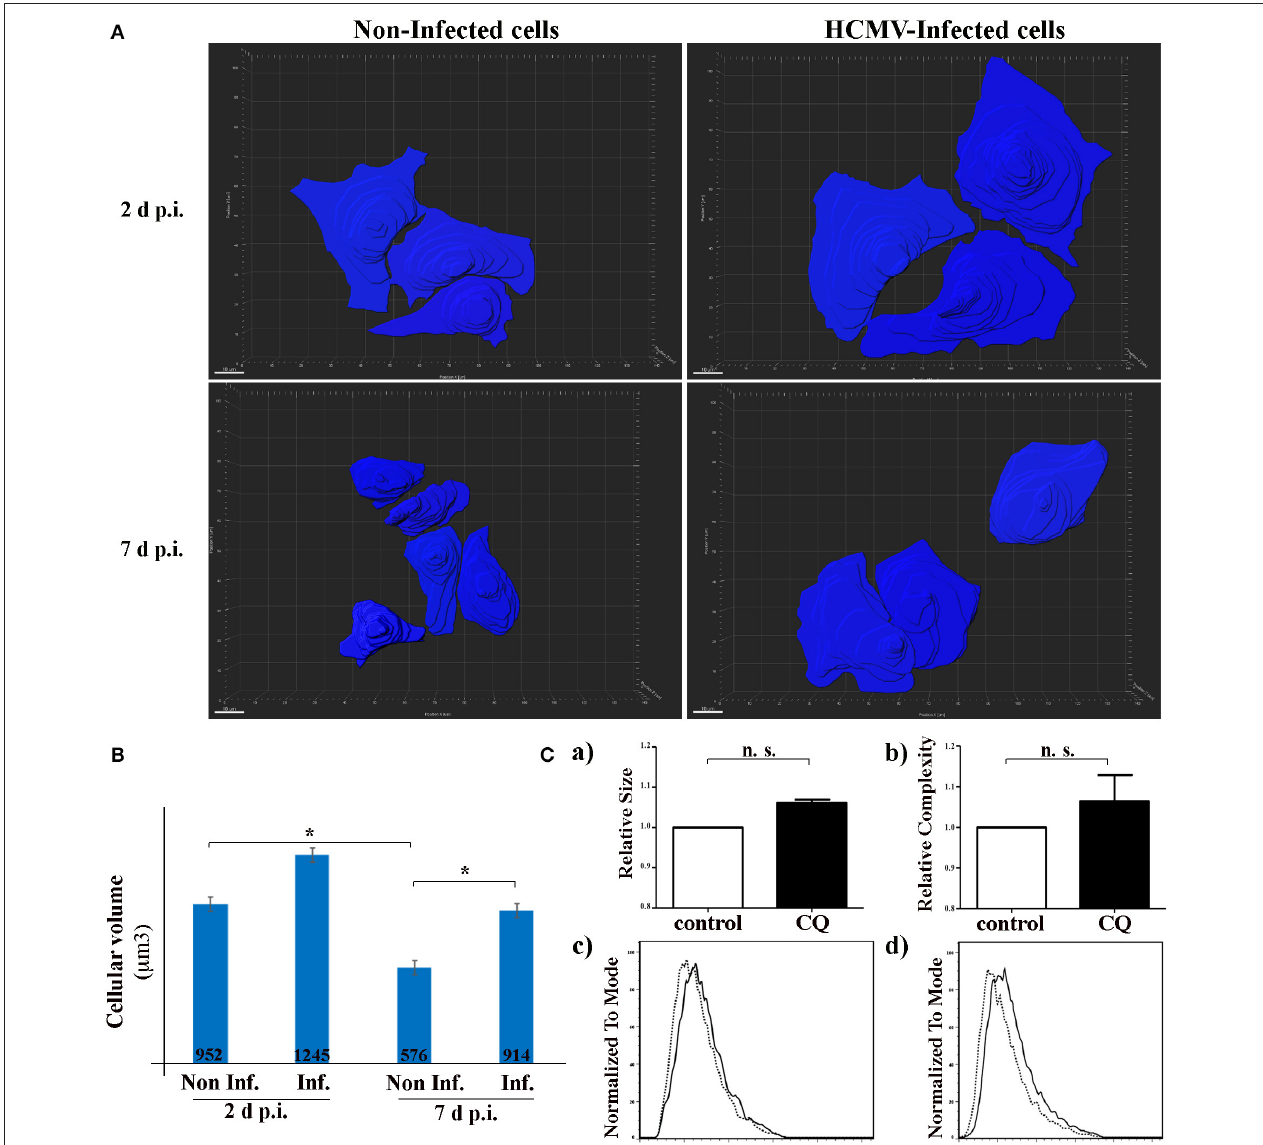
FIGURE 4 | HCMV controls the size of HK-2 cells during infection. (A) 3D reconstruction of non-infected- and HCMV-infected HK-2 cells, 48h and 7 d p.i., using over-saturated LC3 staining images to observe the complete cell and Imaris Software to represent cell size. Scale bar represent 10 µ m (B) Bar graph showing quantification of the mean cell volume of non-infected and infected cells. * p < 0.05 (ANOVA, with a Tukey contrast) (C) Human epithelial HeLa cells were treated for 4h with CQ or left in control condition. Bar graphs indicating (a) size or (b) cellular complexity of cells treated with CQ or untreated (control). Representative flow cytometry histograms showing the size (c) or cellular complexity (d) of HeLa cells treated with CQ or untreated (control). Images are representative of three independent